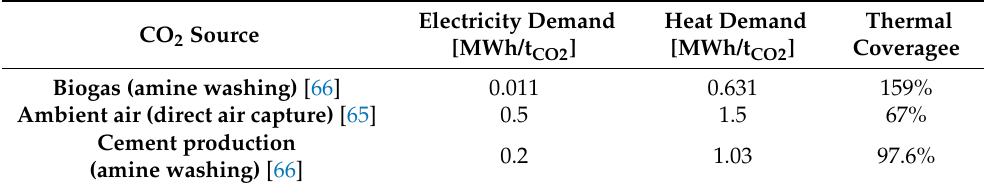
Table 3. Thermal coverage for CO 2 separation from various CO 2